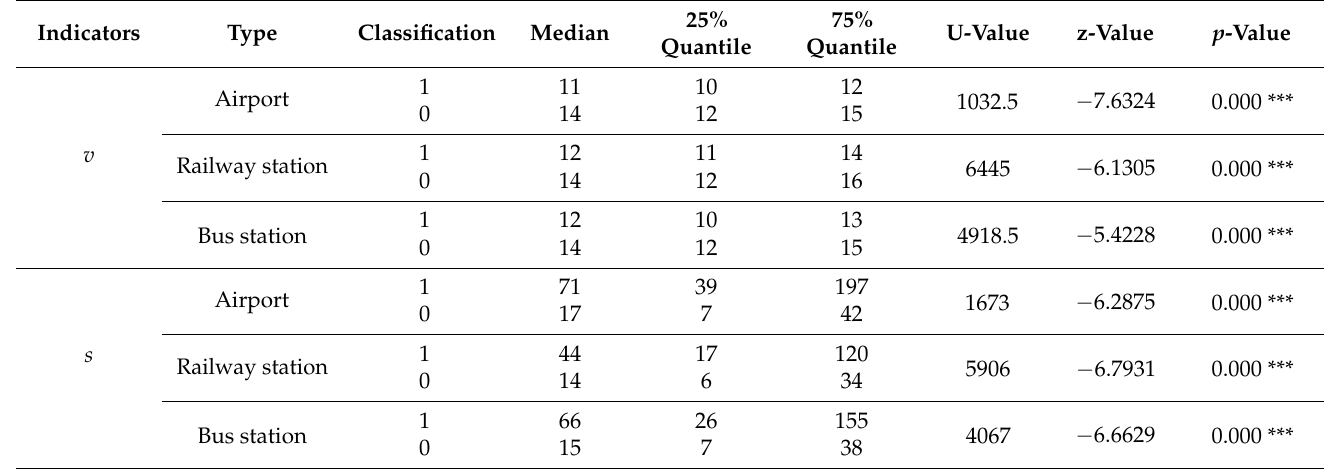
Table 5. Results of the Mann–Whitney U test.